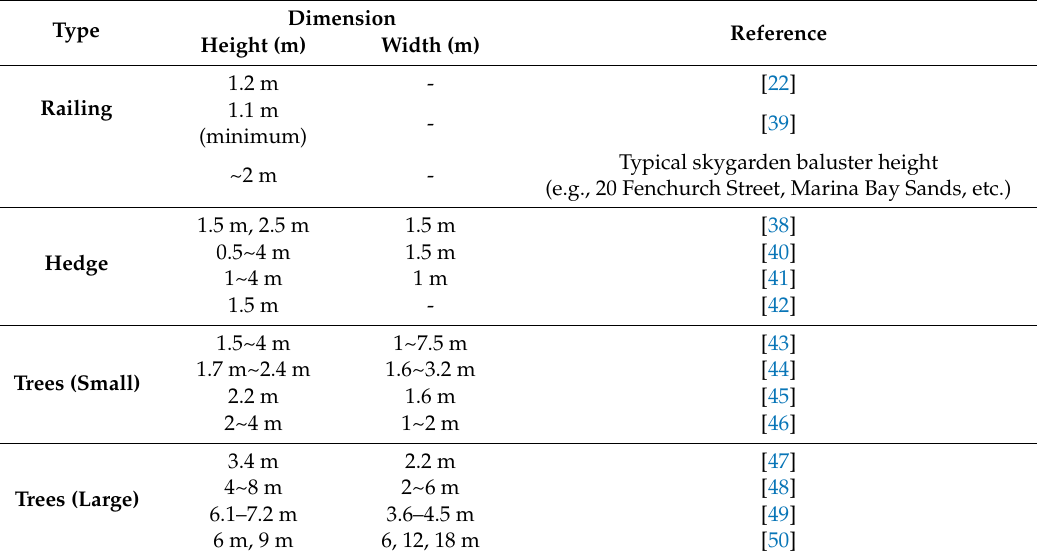
Table 1. Studies which modelled railings, hedges, and